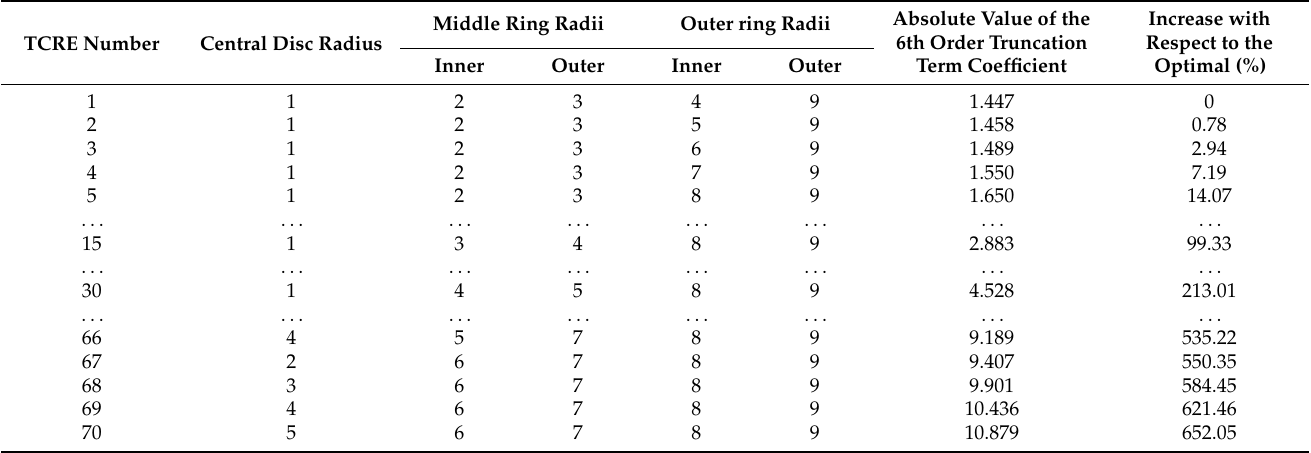
Table 2. Select TCRE configurations for the outer radius of the outer ring equal to 9. TCRE Number Central Disc